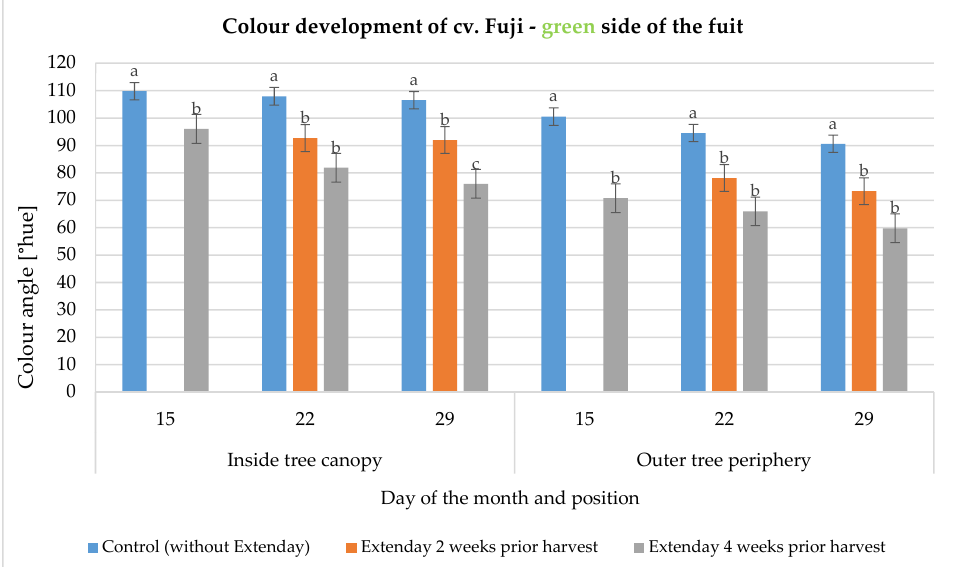
Figure 7. Colour development dependent on fruit position within the tree of cv. Fuji as measured on 15, 22 and 29 March on the inner green side of the fruit as affected by reflective mulch. (Treatments with different letter for the same position of the fruit within the same day are statistically different ( p < 0.05) (n = 60 fruit per treatment per position)).